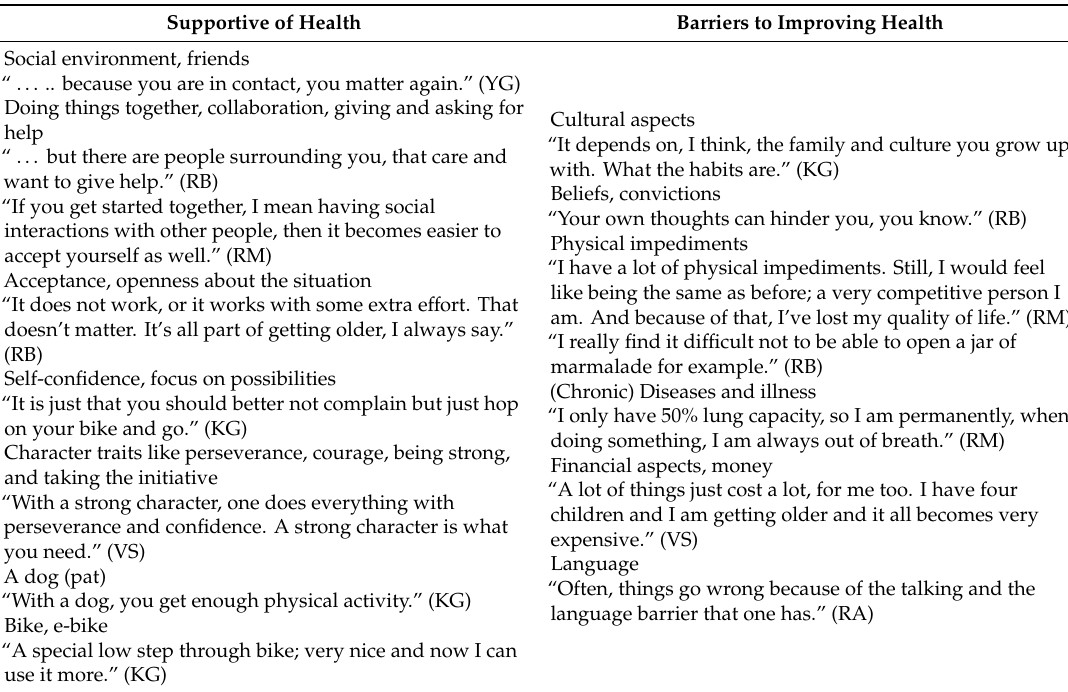
Table 4. Needs and barriers to improving